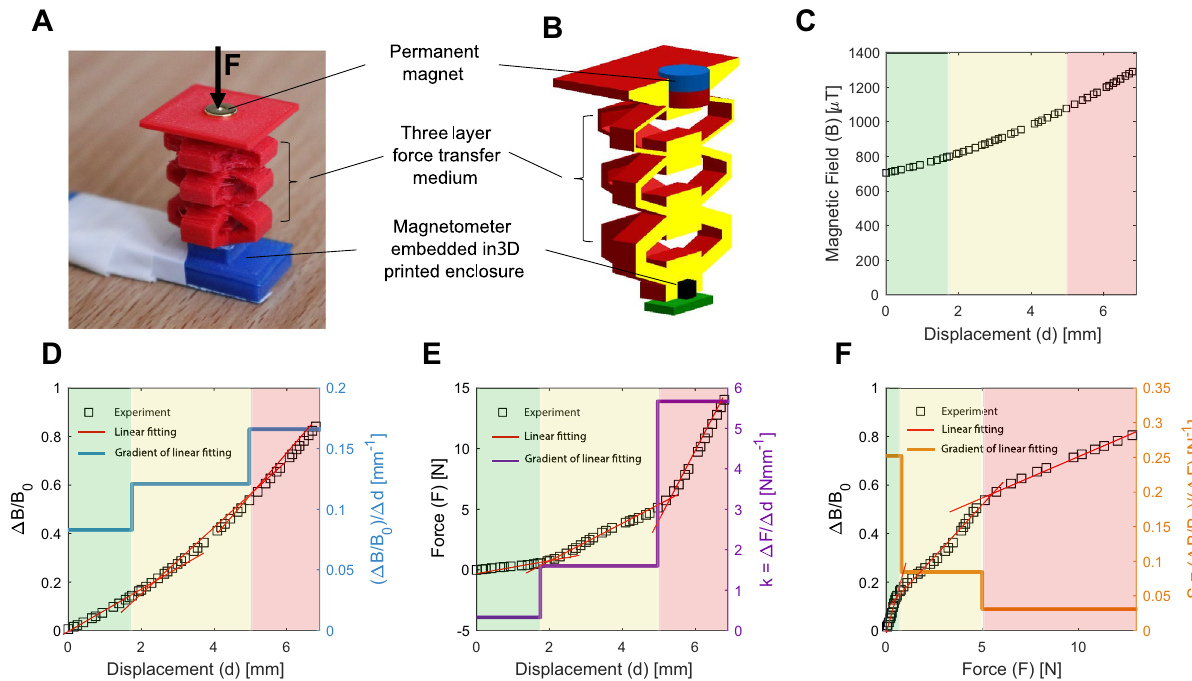
Figure 2. Magnetic-based transduction method of the MST Sensor. ( A ) A single three-layer block with integrated permanent magnet as stimulus, and magnetometer covered by a 3D printed holder. ( B ) Schematic cross-section of the single block. ( C ) The variation of the overall magnetic field with respect to the displacement of the permanent magnet in the top layer. ( D ) The variation of the � B / B 0 with respect to the permanent magnet displacement (left y-axis), linear fitting (red lines) at three locking stages (highlighted background in green, yellow, and red), and gradient of linear fitting (right y-axis) corresponding to (� B / B 0 )/� d . ( E) The variation of the applied force with respect to the displacement of top layer (left y-axis) linear fitting (red lines) at three locking stages, and gradient of linear fitting (right y-axis), corresponding to the stiffness of different layers of the block ( k = � F /� d ). ( F ) The variation of the � B / B 0 with respect to the applied force (left y-axis), linear fitting (red lines) at three locking stages, and gradient of linear fitting (right y-axis), corresponding to the multiple sensitivities of the MST sensor at different force sensing ranges ( S = (� B / B 0 )/� F